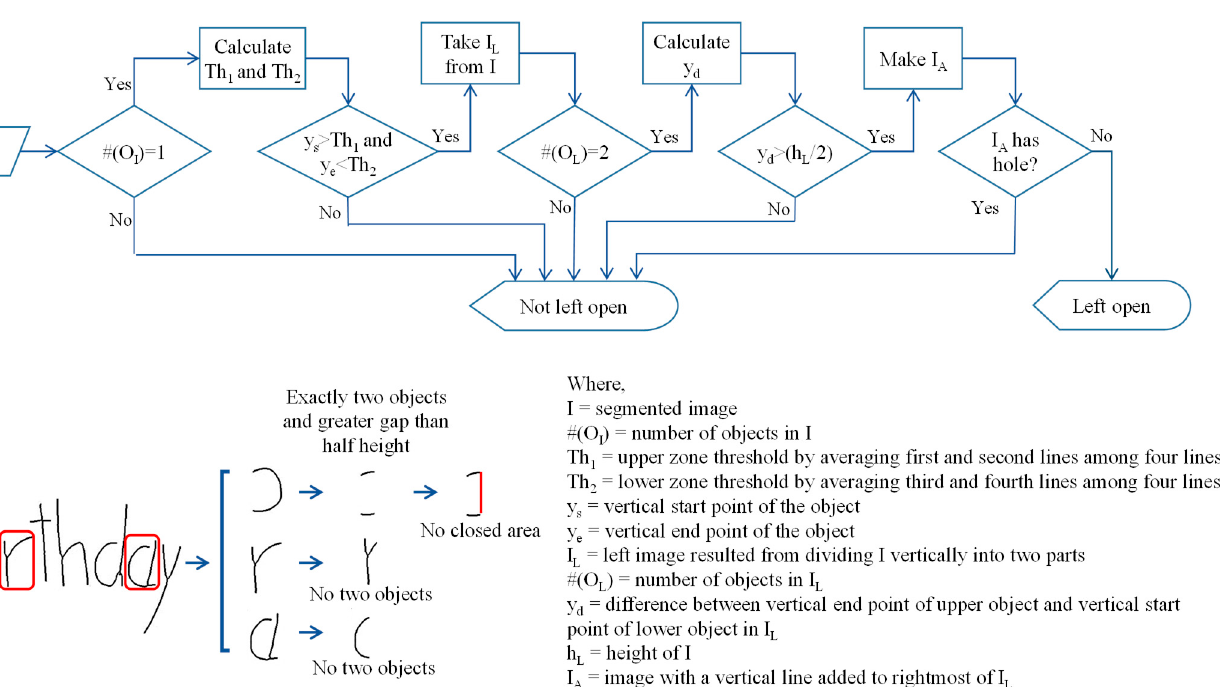
Figure 5. Left open detection flowchart with illustrated image.